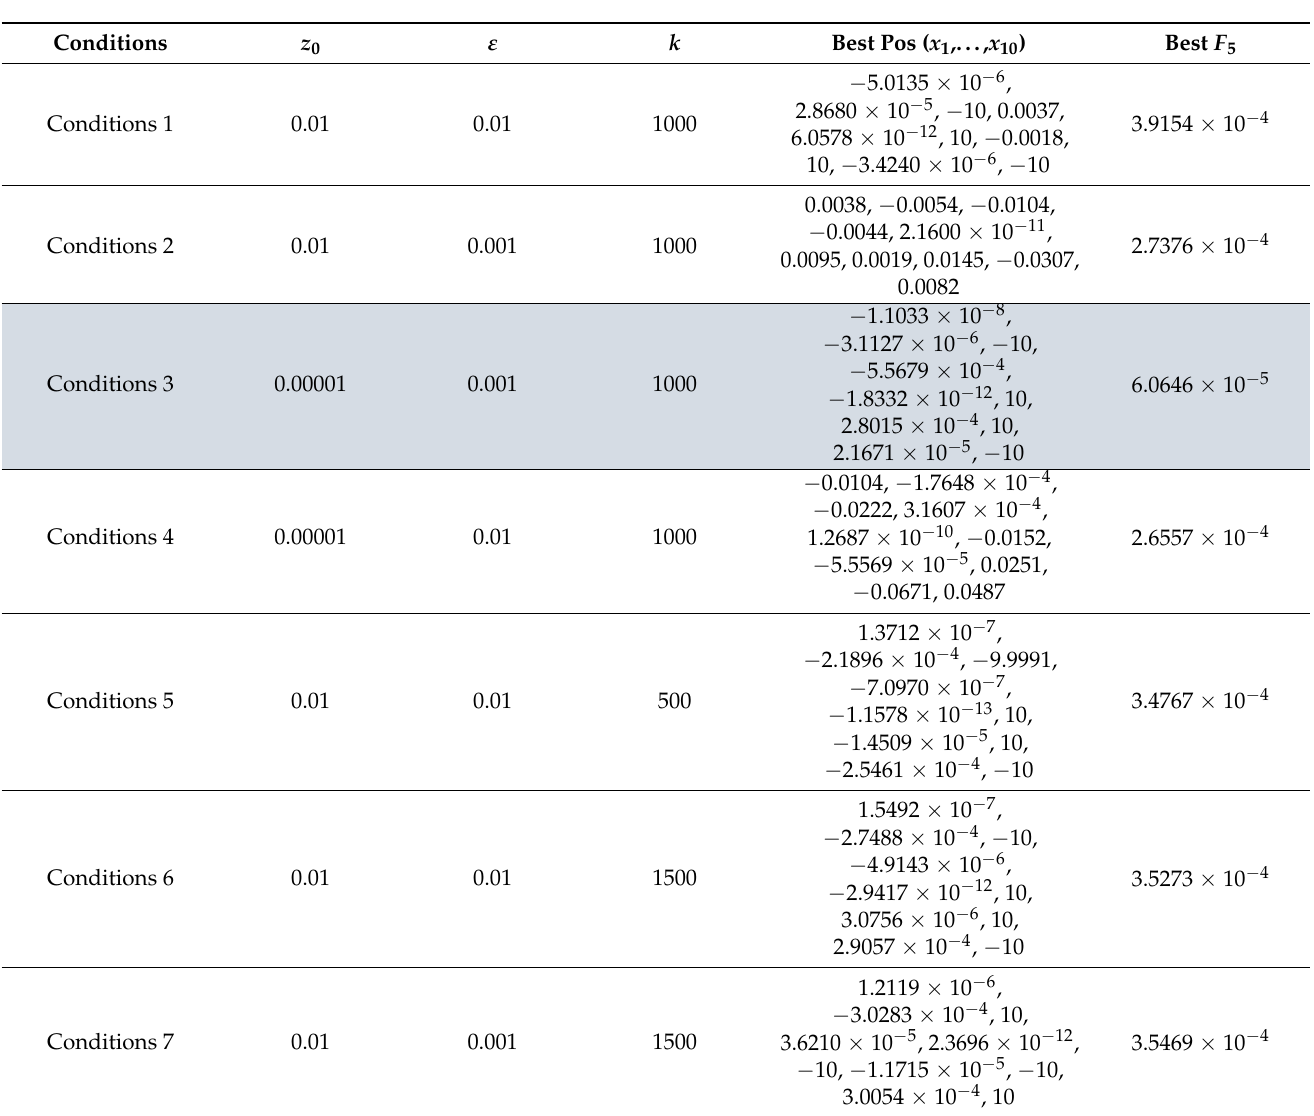
Table 8. Results of Case 5: F 5 at different